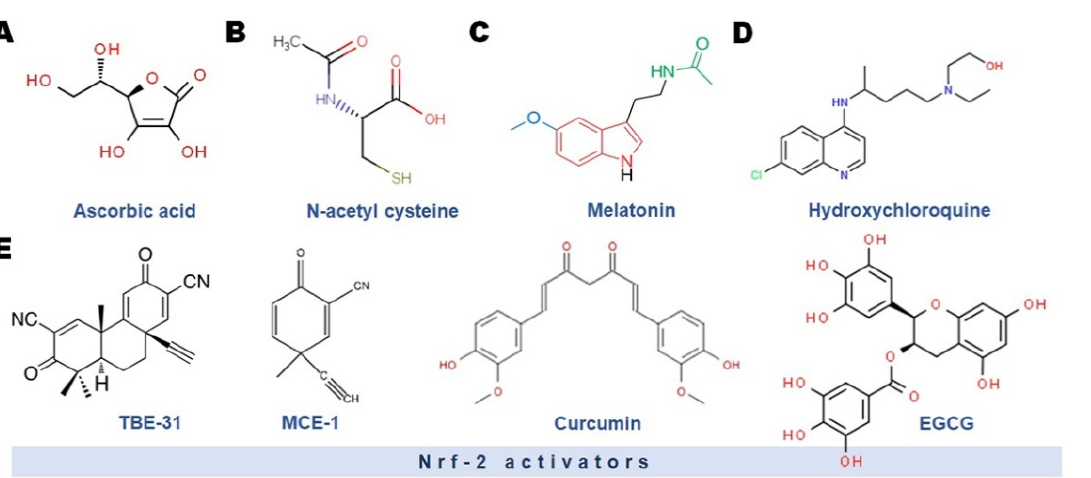
Figure 2. Most common antioxidants used in the management of SARS-CoV-2 infection.